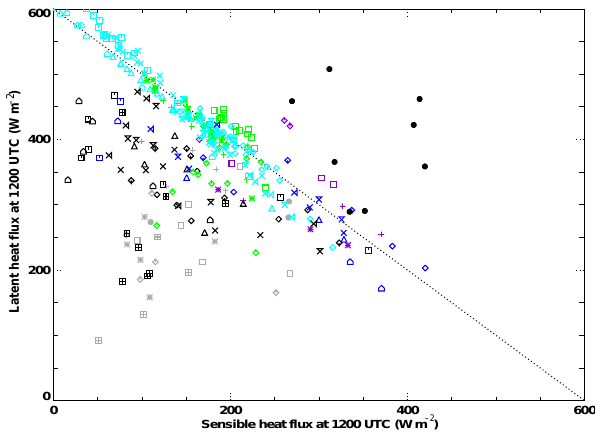
Figure 12. Latent heat flux vs. sensible heat flux at 12:00UTC in observations (in black for clear days and grey for cloudy days; the dots correspond to the observations over the forest, while the crossed squares correspond to the observations at 60m in the 60m- tower) and models (AROME in cyan for clear days and green for cloudy days and ARPEGE in blue for clear days and purple for cloudy days). One symbol is plotted for each